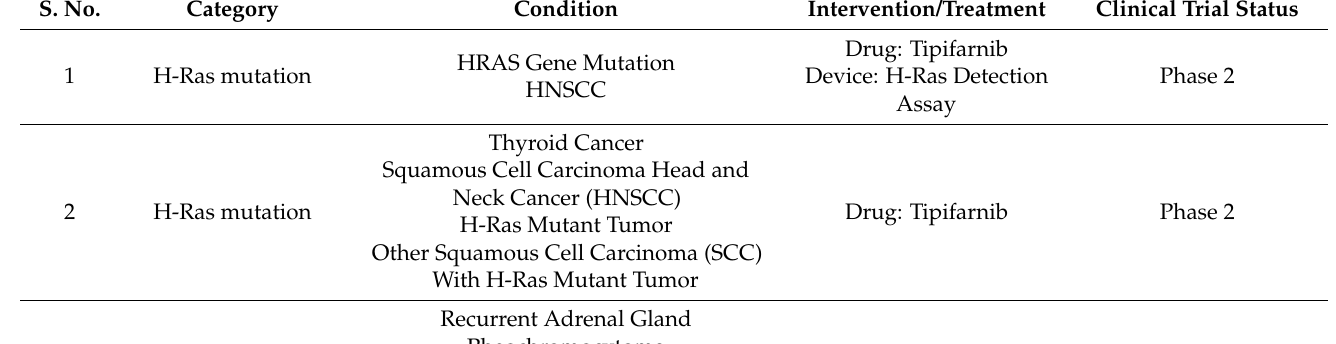
Table 3. Various drug/interventions currently under clinical trial for H-Ras, K-Ras, and N-Ras. The table is compiled using data from NIH-U.S library of medicine- ClinicalTrials.gov (www.clinicaltrials.gov), (accessed on 26 May 2021). S.